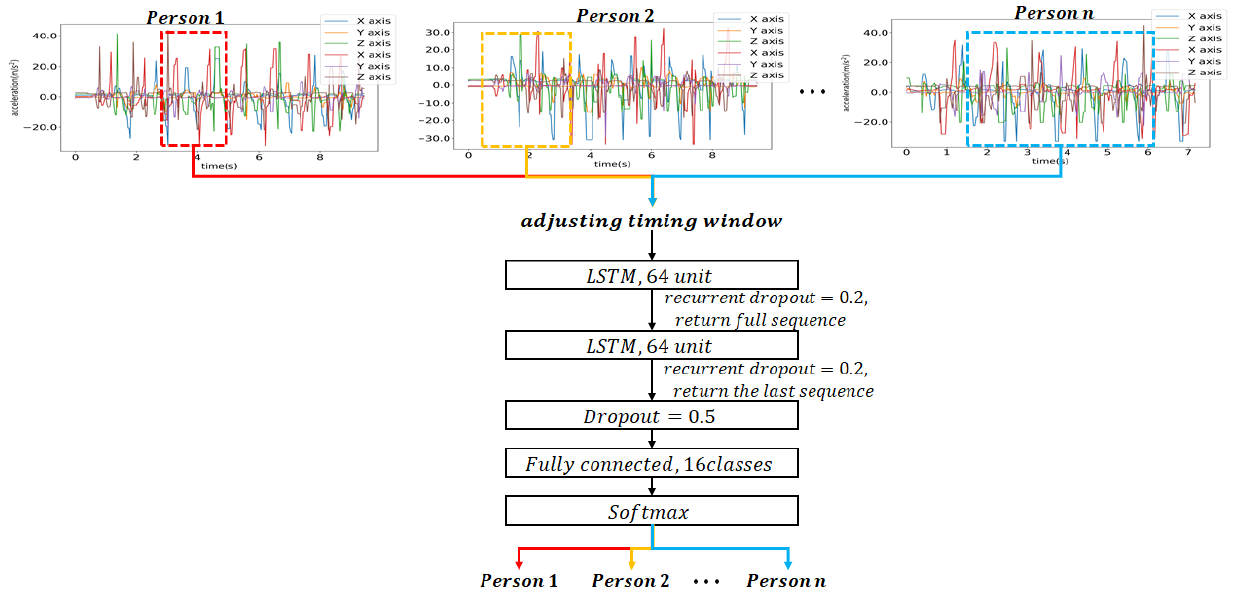
Figure 8. The designed LSTM network considering the variable window